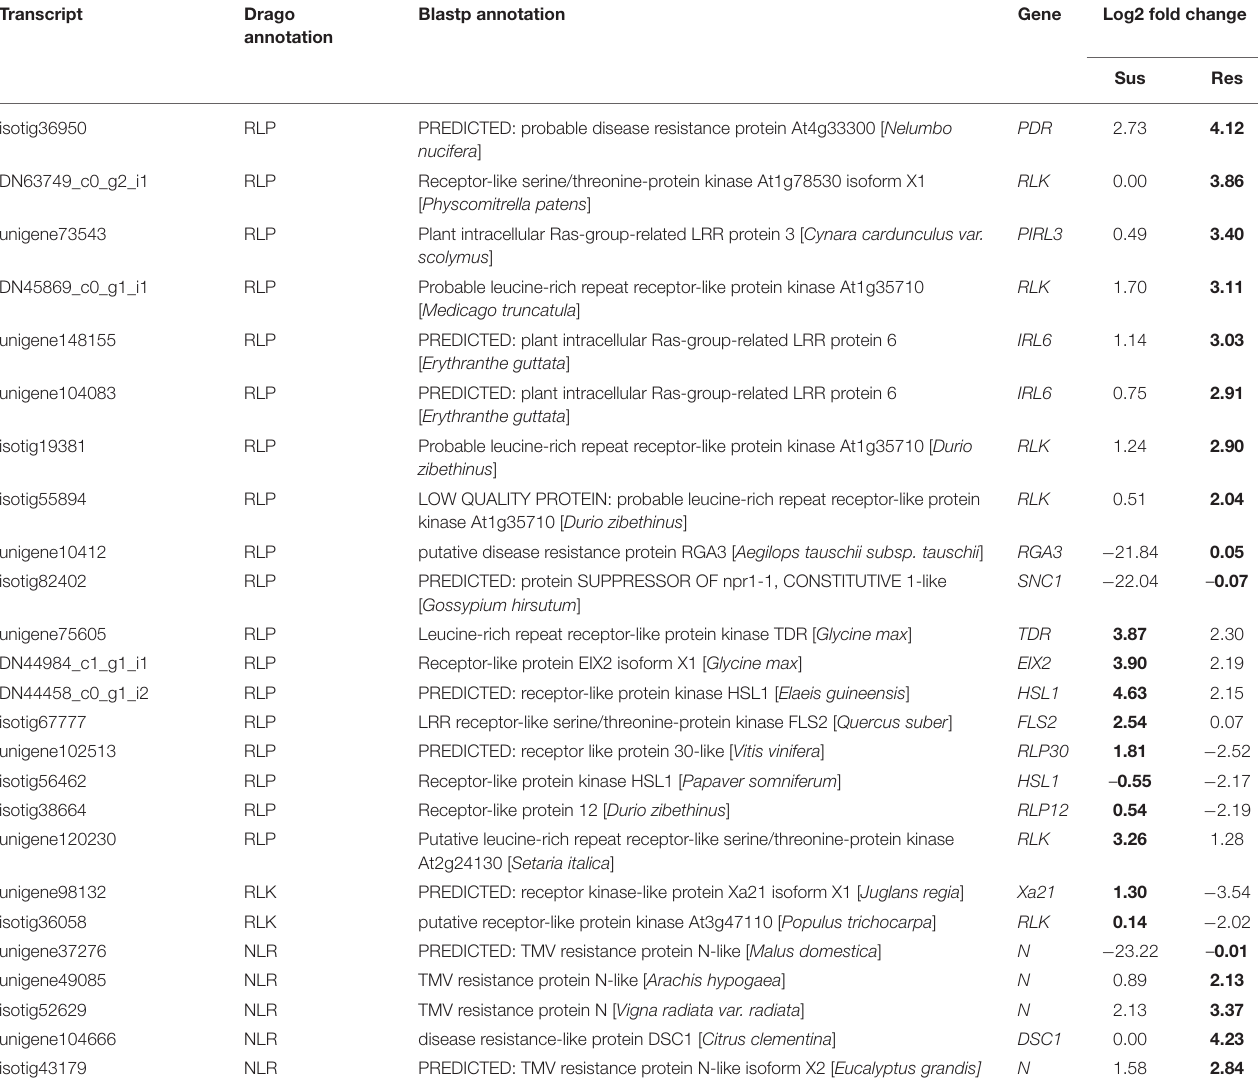
TABLE 1 | Putative resistance genes detected by DRAGO tool (selected).